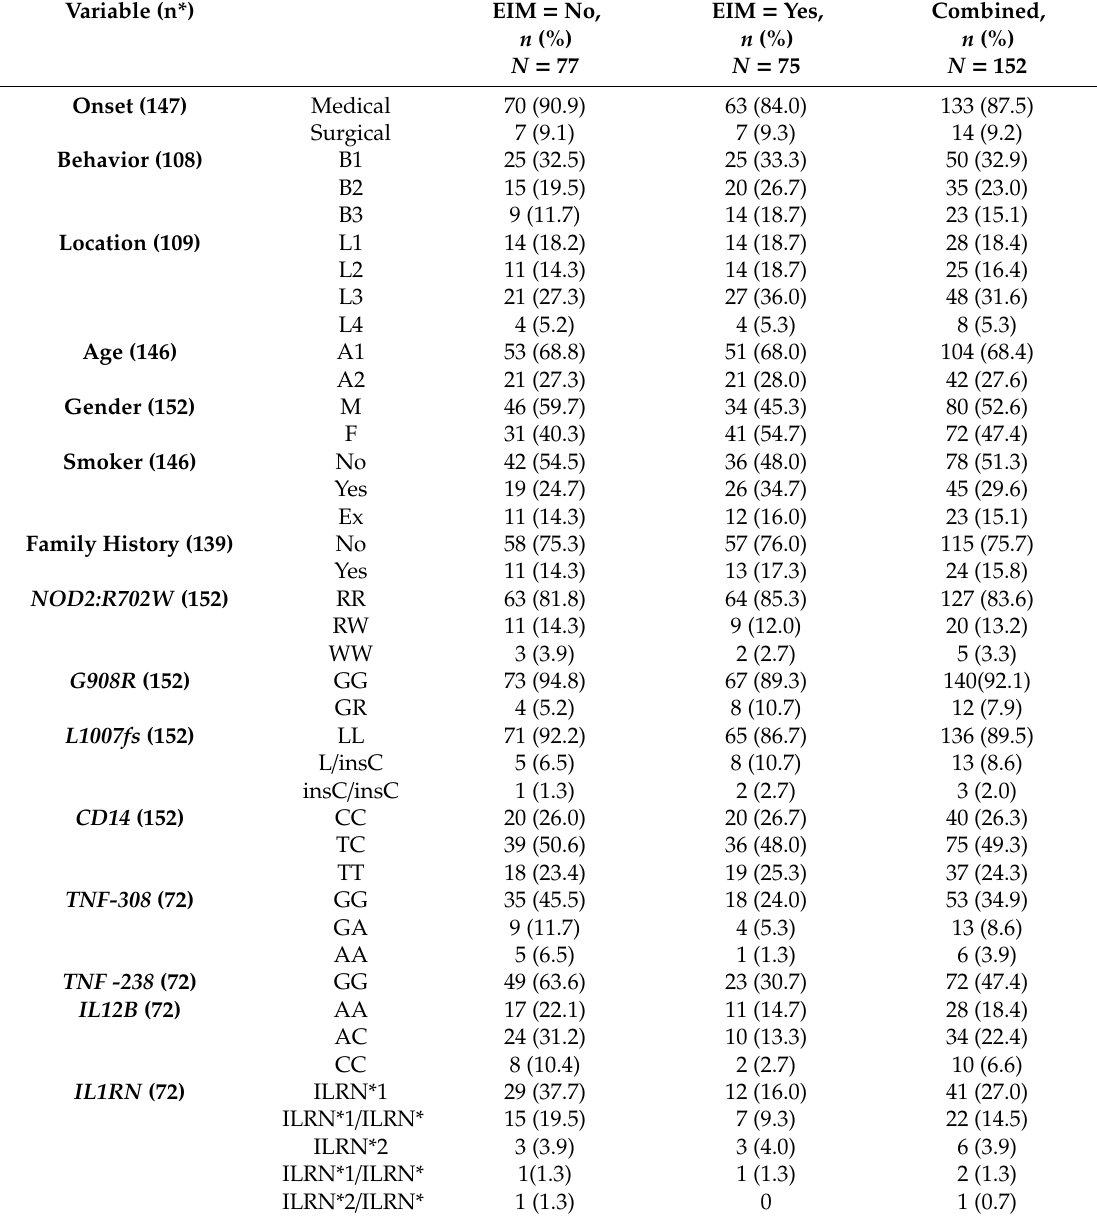
Table 1. Distributions of patient characteristics across the absence or presence of EIMs. EIMs = No indicates absence of EIMs, EIMs = Yes indicates presence of EIMs. n * refers to the number of records without missing